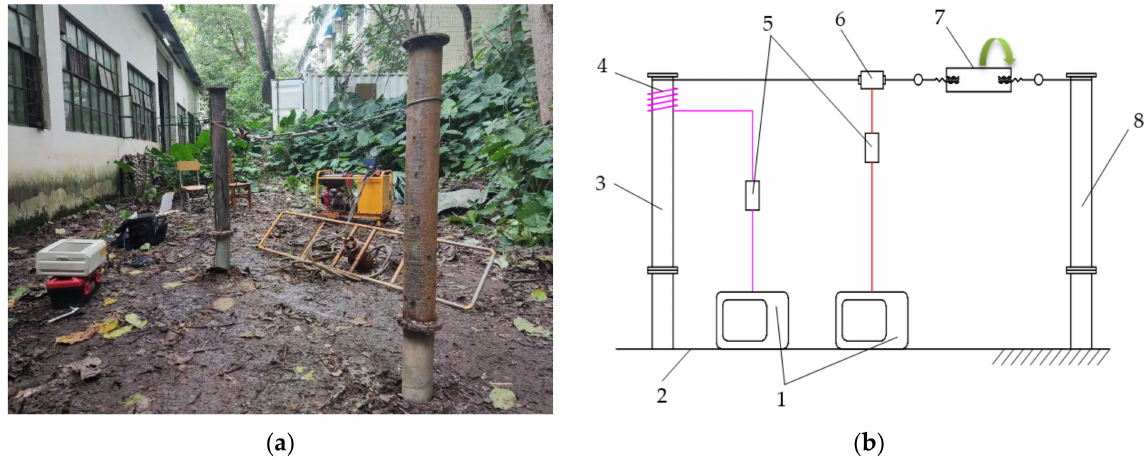
Figure 9. ( a ) Field loading test; ( b ) Test measurement system. 1—Data acquisition system; 2—Sinking pile ground; 3—Spliced pile; 4—Strain gauge and winding wire; 5—Bridge box; 6—Tension sensor; 7—Afterburner; 8—Auxiliary